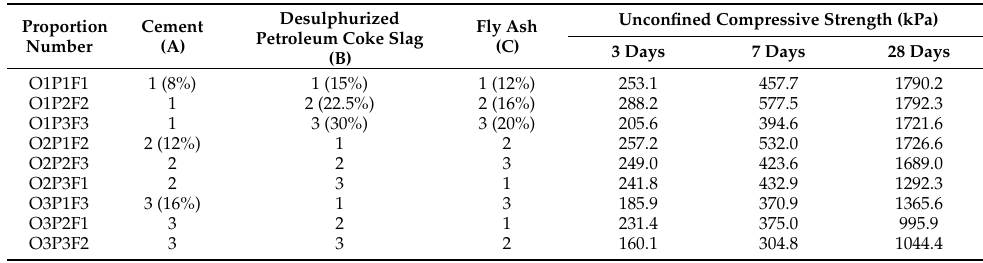
Table 6. Results of orthogonal